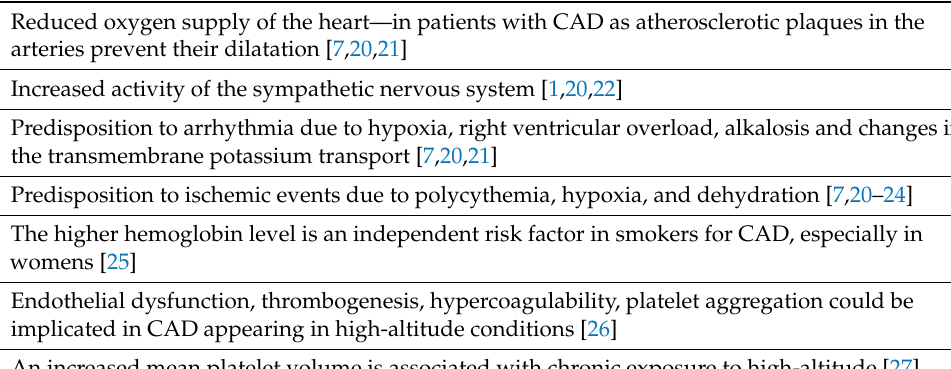
Table 2. Pathophysiological changes in high-altitude